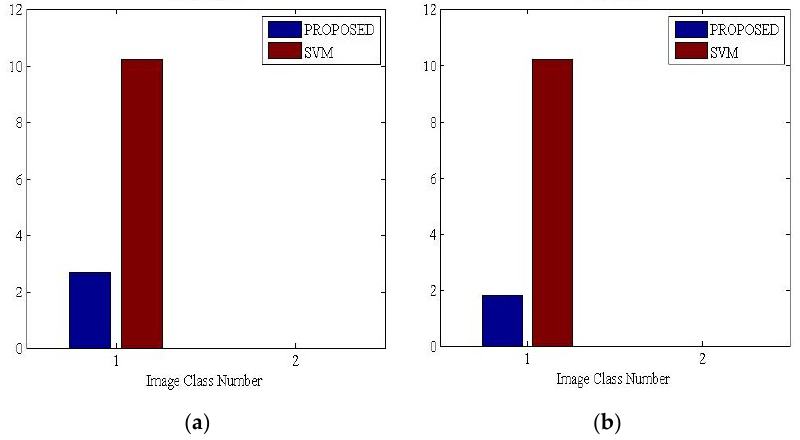
Electronics 2022 , 11 , x FOR PEER REVIEW Figure 9. FAR analysis for: ( a ) Indian Pines and ( b ) Pavia University. Figure 9. FAR analysis for: ( a ) Indian Pines and ( b ) Pavia University.